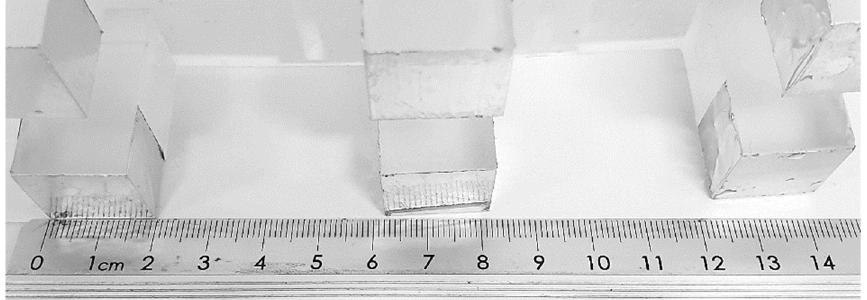
Figure 10. Bending of the 3D printed 12 BP leading to misalignment of the BP in the SLA apparatus.